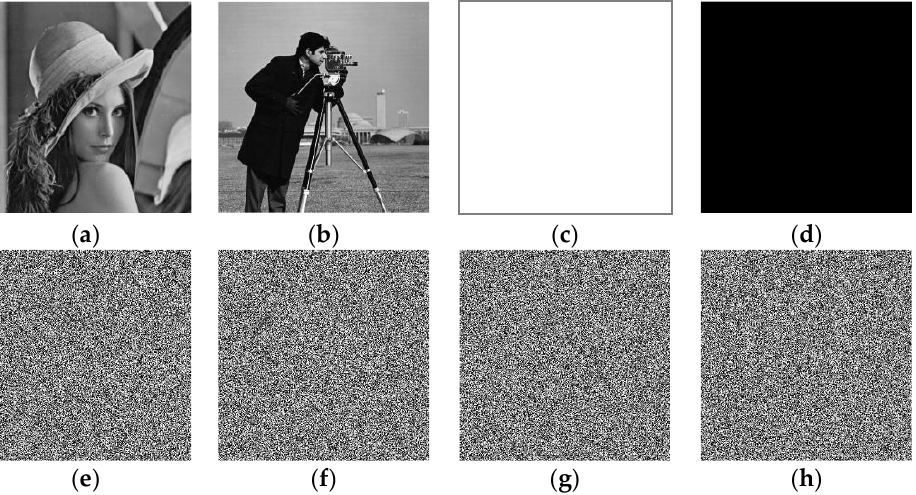
Figure 8. The test images and the encrypted results. ( a ) The image Lena. ( b ) The image Cameraman. ( c ) The all-white image. ( d ) The all-black image. ( e ) The encrypted image Lena. ( f ) The encrypted image Cameraman. ( g ) The encrypted all-white image. ( h ) The encrypted all-black image.